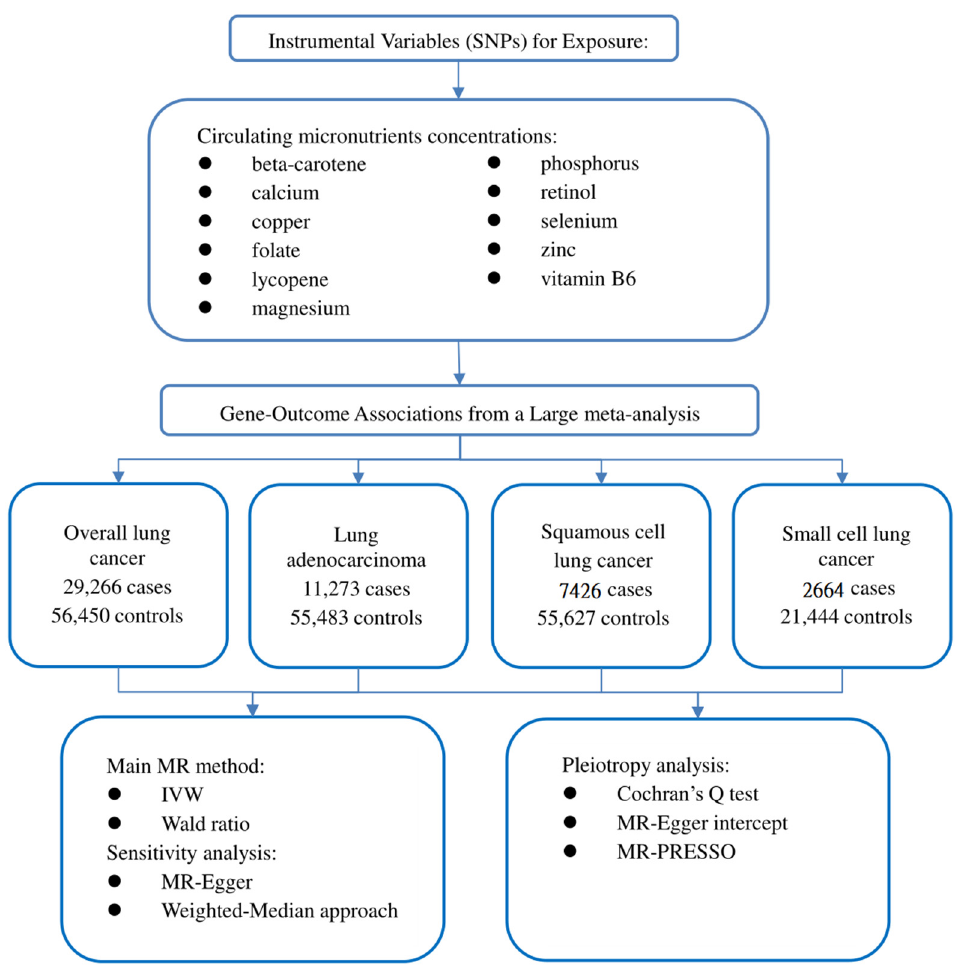
Figure 1. Flow chart of our study design.